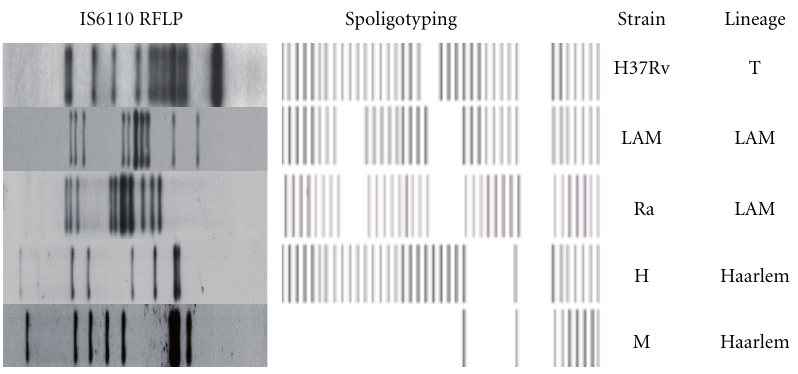
Figure 1: Spoligotyping and IS6110-RFLP pattern profiles of Mtb strains used as antigens in this study: reference virulent strain H37Rv, local-drug-sensitive (LAM, 10406) and drug-resistant (Ra, 11608) LAM strains, drug-sensitive Haarlem strain (H, 12425), and MDR Haarlem strain, M